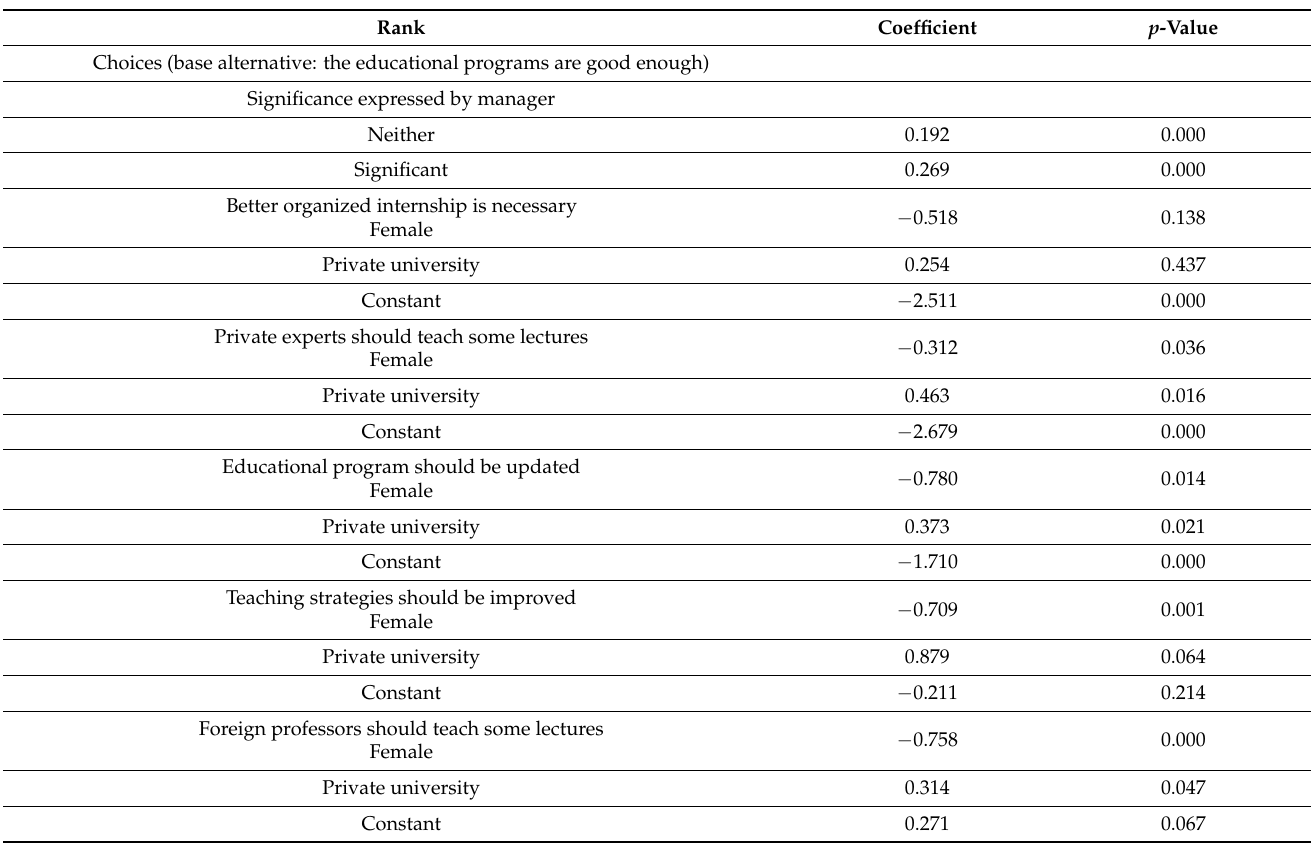
Table 2. The results of rank-ordered probit choice